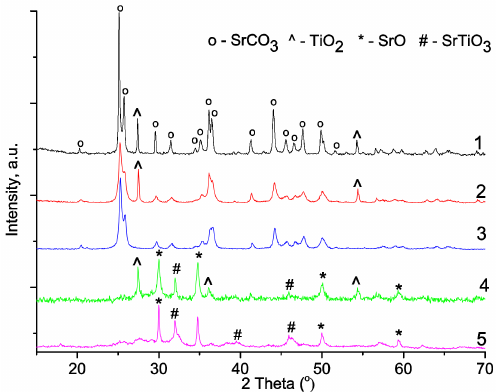
Figure 1. XRD patterns of the physical mixture (SrCO 3 + TiO 2 ) (1) and MA products. MA-1 (2), MA-2 (3), MA-3 (4), MA-4 (5).